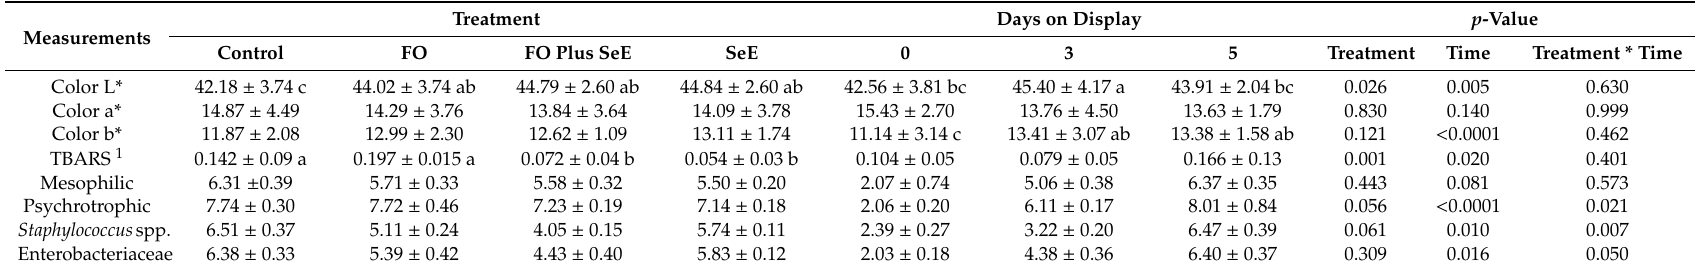
Table 5. Meat color, lipid peroxidation (TBARS) and microbiological quality as measures of the shelf life of meat (means ± s.d.) of Dorper x Santa Ines lambs fed a high-concentrate diet with di ff erent